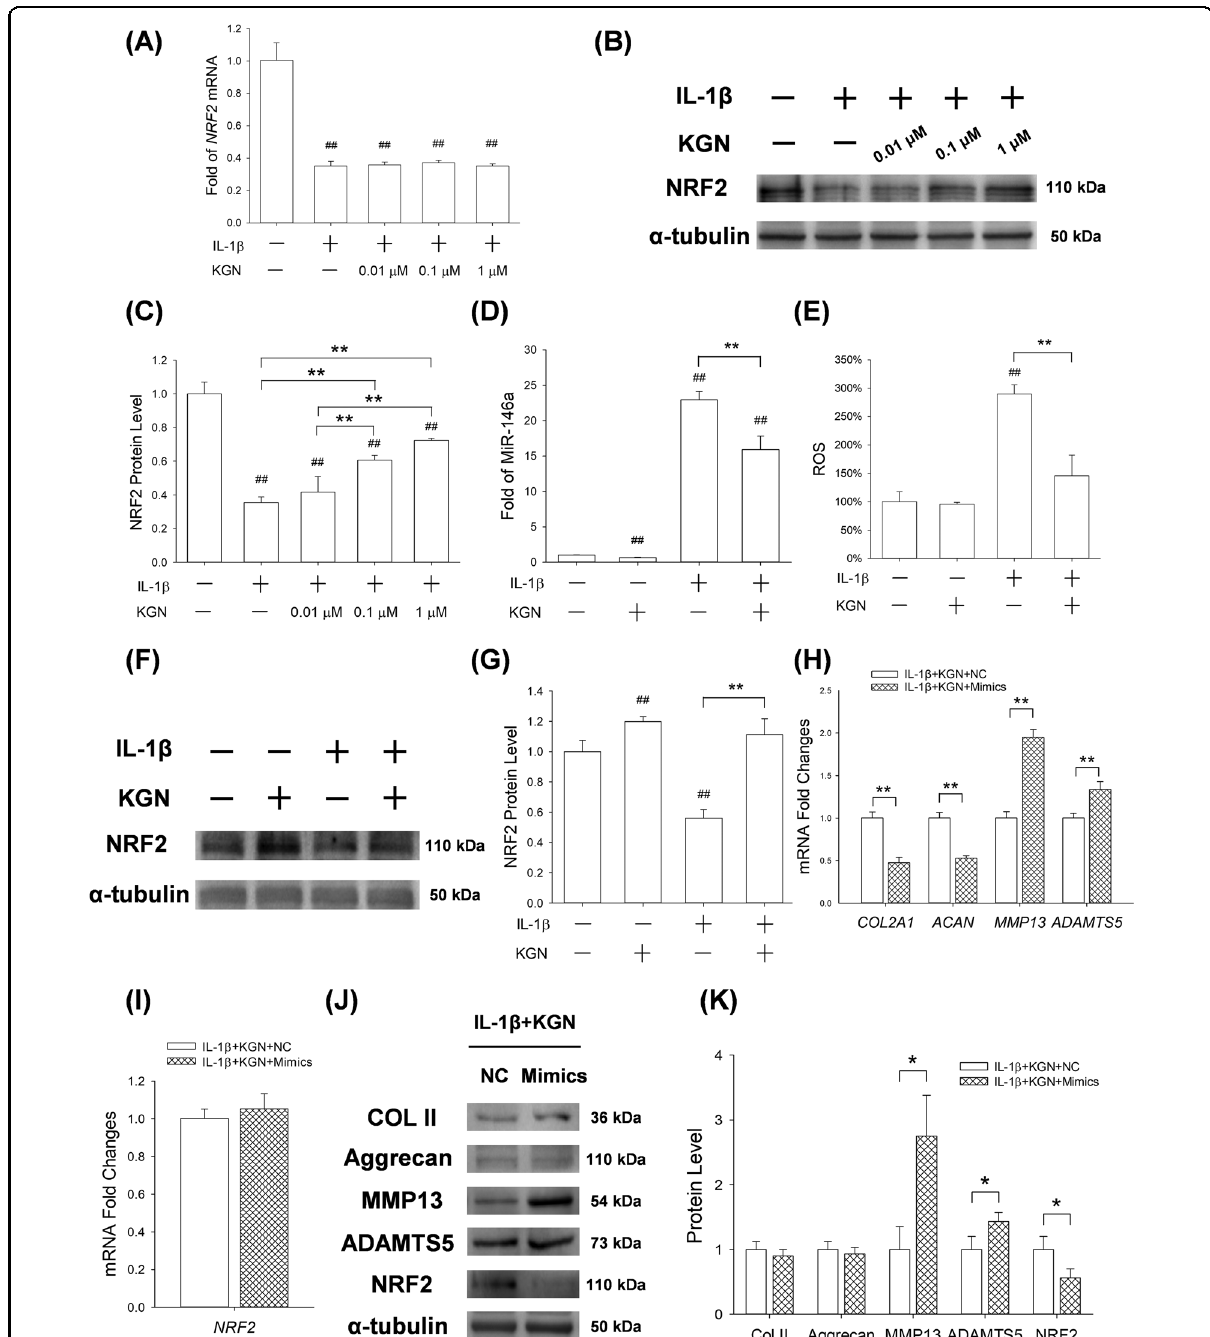
Fig. 6 Effect of up-regulated expression of miR-146a on protective effects of KGN on cartilage matrix synthesis and the expression of NRF2 proteins in chondrocytes. Chondrocytes were treated with 5 ng/mL of IL-1 β and subsequently 1 μ M of KGN after transfection with miRNA- 146a mimics. A RT-PCR analysis for the expression of NRF2 mRNA in chondrocytes. B – C Western blot assay for the expression of NRF2 proteins in chondrocytes. D RT-PCR analysis for the expression of miRNA-146a in chondrocytes. ( E ) Flow cytometric analysis for the intracellular production of ROS in chondrocytes. F – G The effects of KGN on NRF2 expression in both untreated and IL-1 β -treated chondrocytes were determined by Western blot assays. H – I qRT-PCR analysis for the expression of mRNAs for COL2A1 , ACAN , MMP13 , ADAMTS5 and NRF2 . J – K Western blot assay for the expression of COL II, aggrecan, MMP13, ADAMTS5 and NRF2 proteins in chondrocytes. Values represent mean ± S.E.M of four replicas for RT-PCR experiments and three replicas for Western blot assays, respectively. (* p < 0.05 and ** p < 0.01; between the indicated groups and # p < 0.05 or ## p < 0 . 01 versus the CTRL